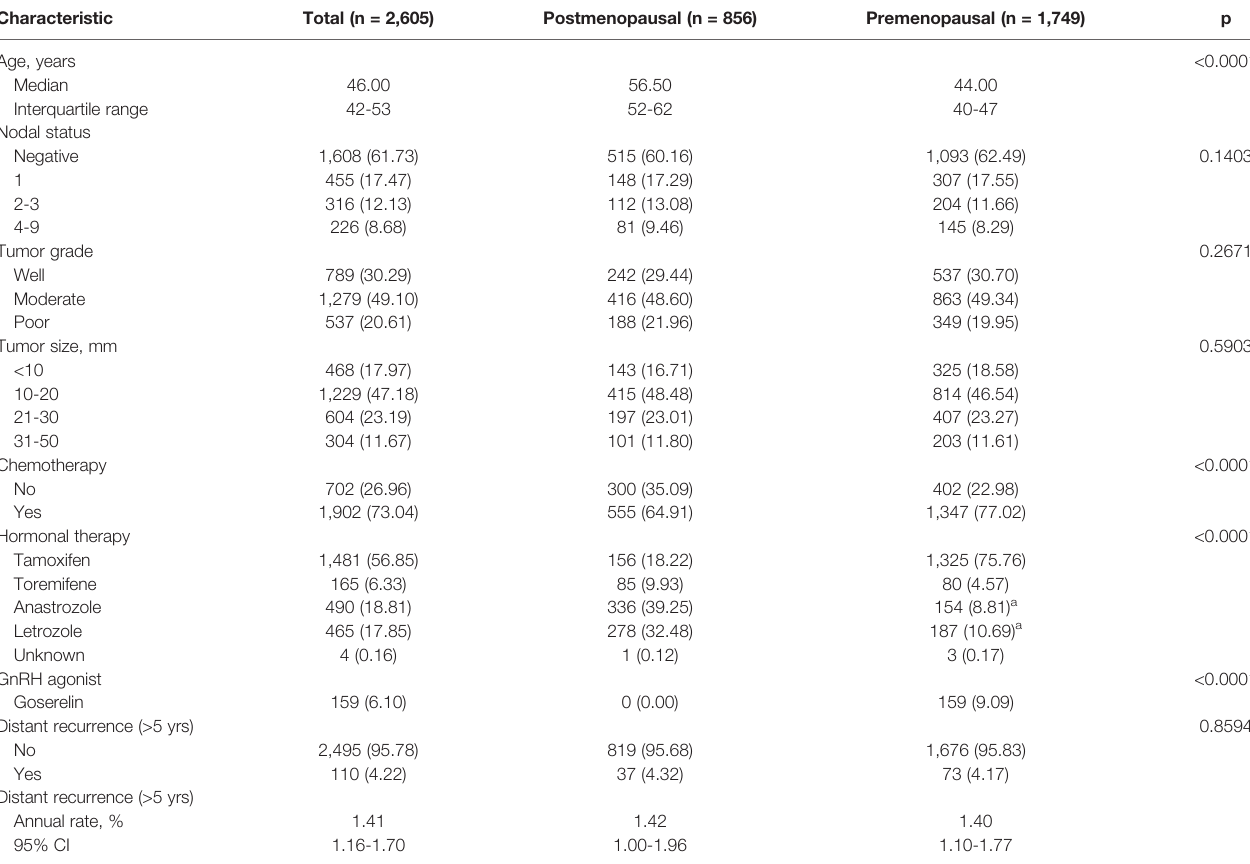
TABLE 1 | Demographic and clinical characteristics between pre- and postmenopausal women.